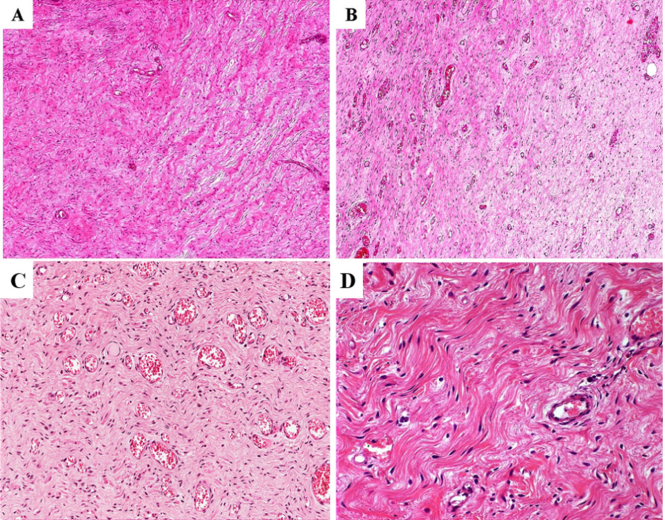
Figure 4. Alternating myxoid to collagenized/fibrous stroma in primary DAMs . ( A , B ) Two differ- ent tumors exhibiting alternating areas with myxoid and fibrous stroma ( C , D ). Two different tumors illustrating a myxofibrillary ( C ) or collagenized/fibrous stroma ( D ) with elongated fibroblastic-like spindled cells with wavy nuclei that are closely associated with thin and/or thick wavy eosinophilic collagen fibers. These tumor areas are closely reminiscent of a neurofibroma. In (ii) seven cases, hypercellular areas that account for 10 to 60% of the entire tumor are observed; although in most cases (five out of seven) hypercellularity was restricted to the perivascular regions (Figure 5A–C) and two tumors were diffusely hypercellular and composed predominantly of fibroblastic-like spindled cells with fascicular pattern (Figure 5D).